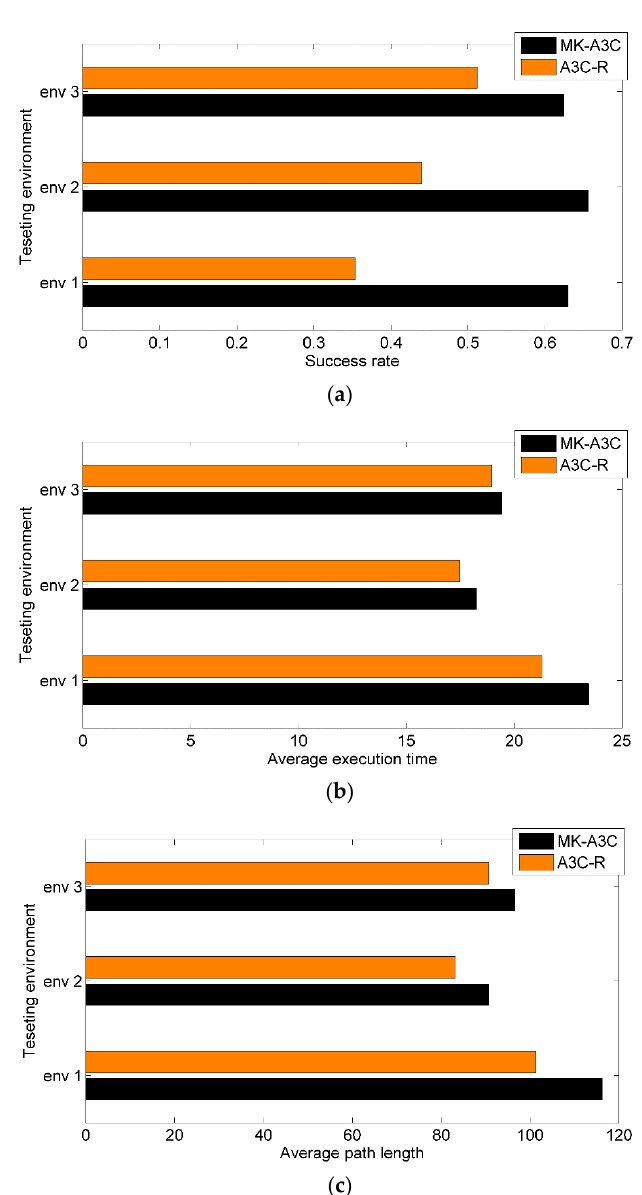
Figure 8. 1000 navigation tasks are generated in each testing environments. ( a ) Success rate denotes the probability of successfully arriving at the destination; ( b ) Average path length denotes the mean path lengths for all successful navigation; ( c ) Average execution time denotes the average value of execution time for all successful